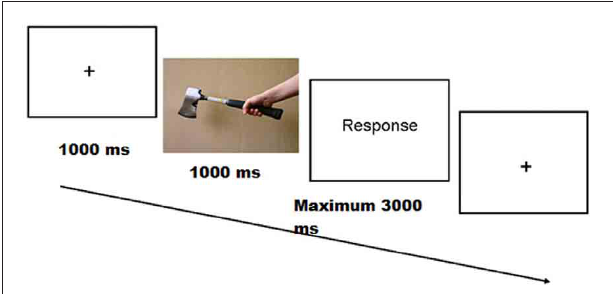
FIGURE 2 | Trial structure used in the experiment. In this example the stimulus is in the congruent grip condition.